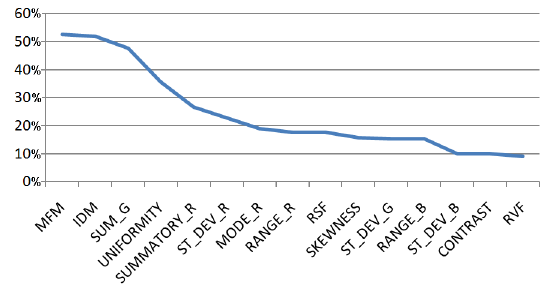
Figure 2: Relevance of features in classification of aerial